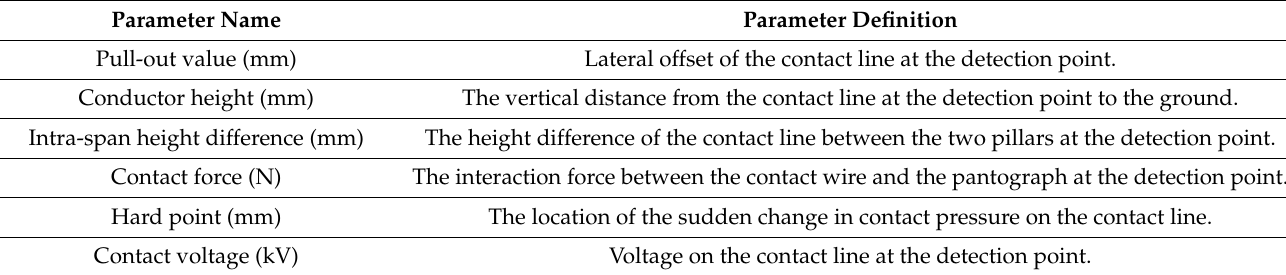
Table 1. Description of the catenary’s primary detection parameters.